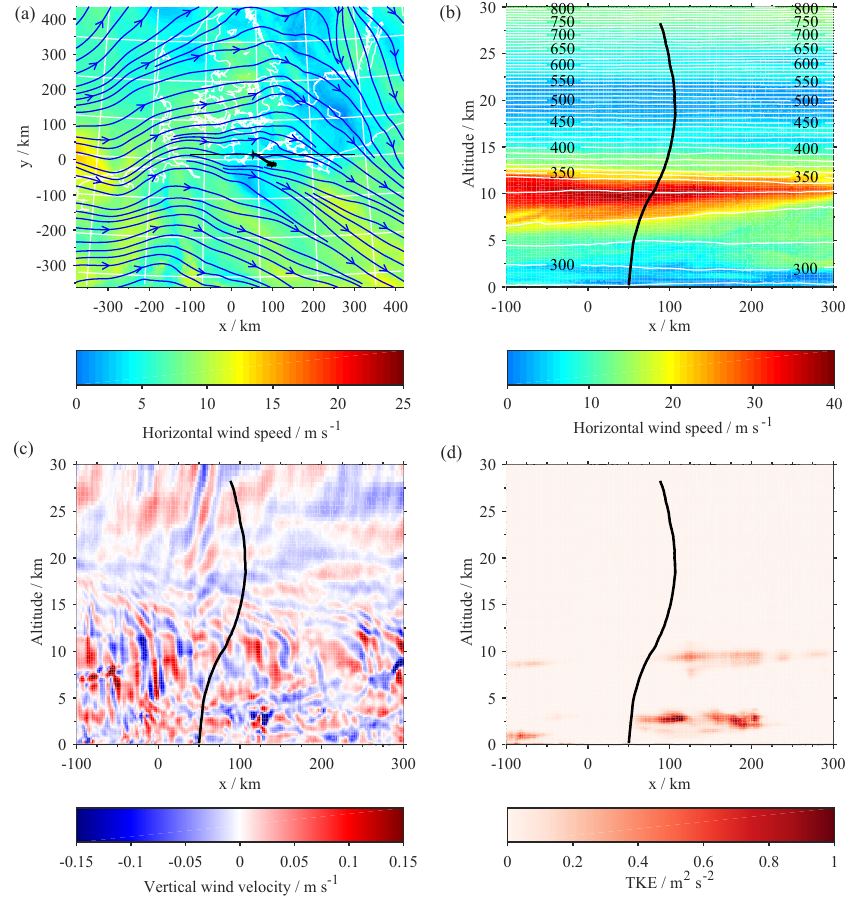
Figure 6. Same as Fig. 2, but for WRF simulations for 11 July 2015,